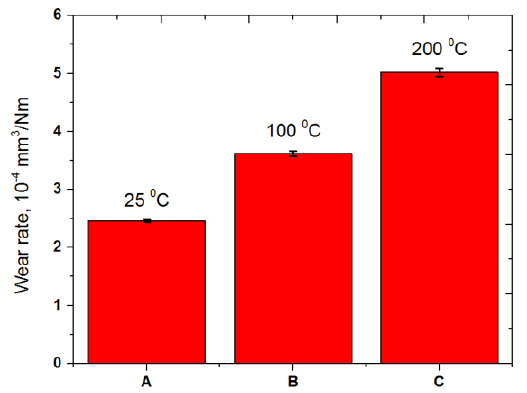
Figure 10. Wear rate of the C/C-SiC composite slid against AISI52100 steel at temperatures of 25, 100, and 200 °C.